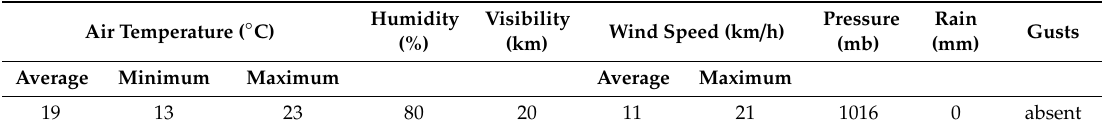
Table 1. Input data of weather conditions.